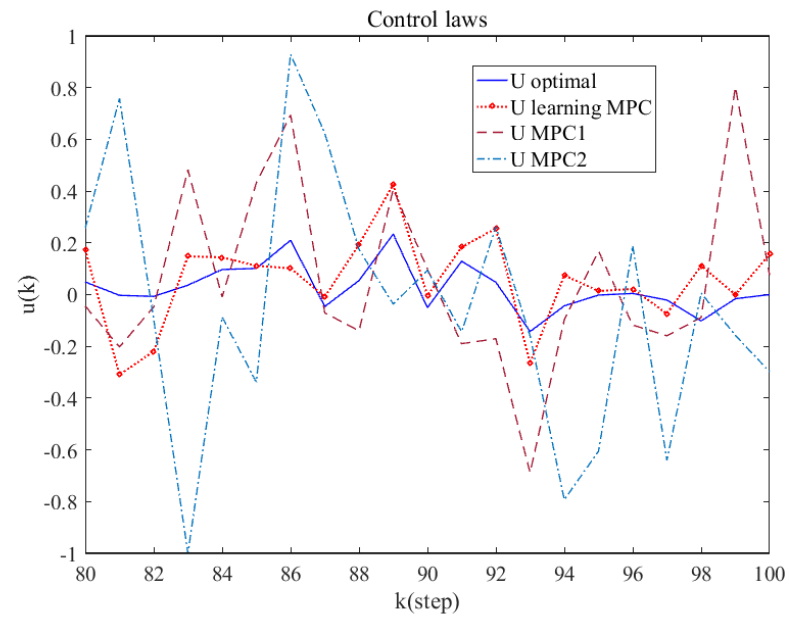
Figure 9. Partial comparison of various MPC control laws. Table 1 shows the calculation time required for each MPC algorithm: Table 1. Calculation time required for each MPC